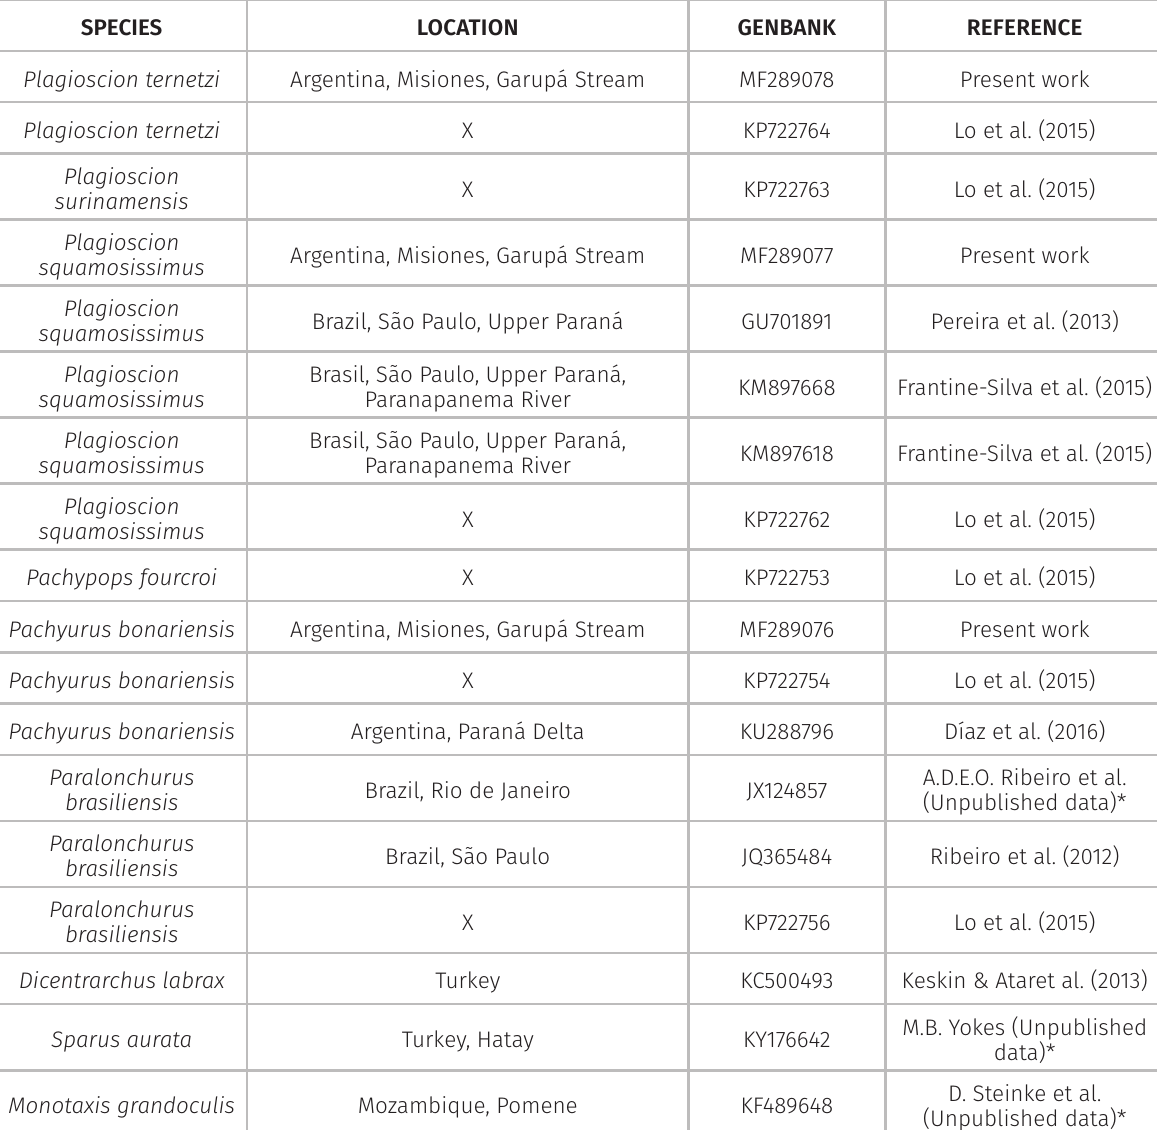
Table I. Summary of the sequences and collection locations of thefor specimens included in this study, as well as those of species assigned to the external group for the COI